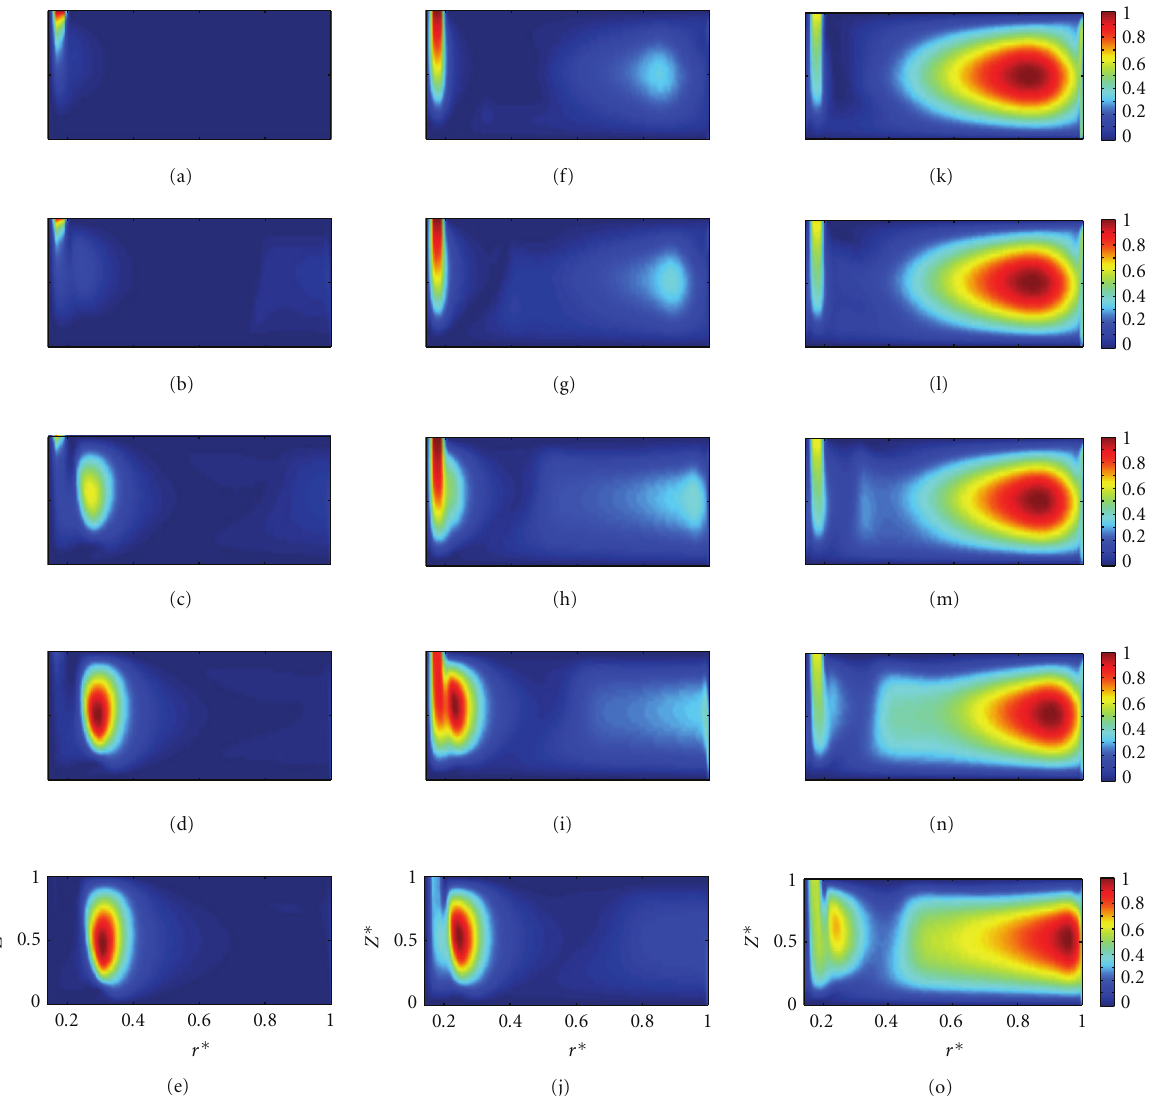
= 1497 . 7; (b) (1 . 8 × 10 5 , max = 2019 . 1; (e) (1 . 8 × 10 5 , − t max